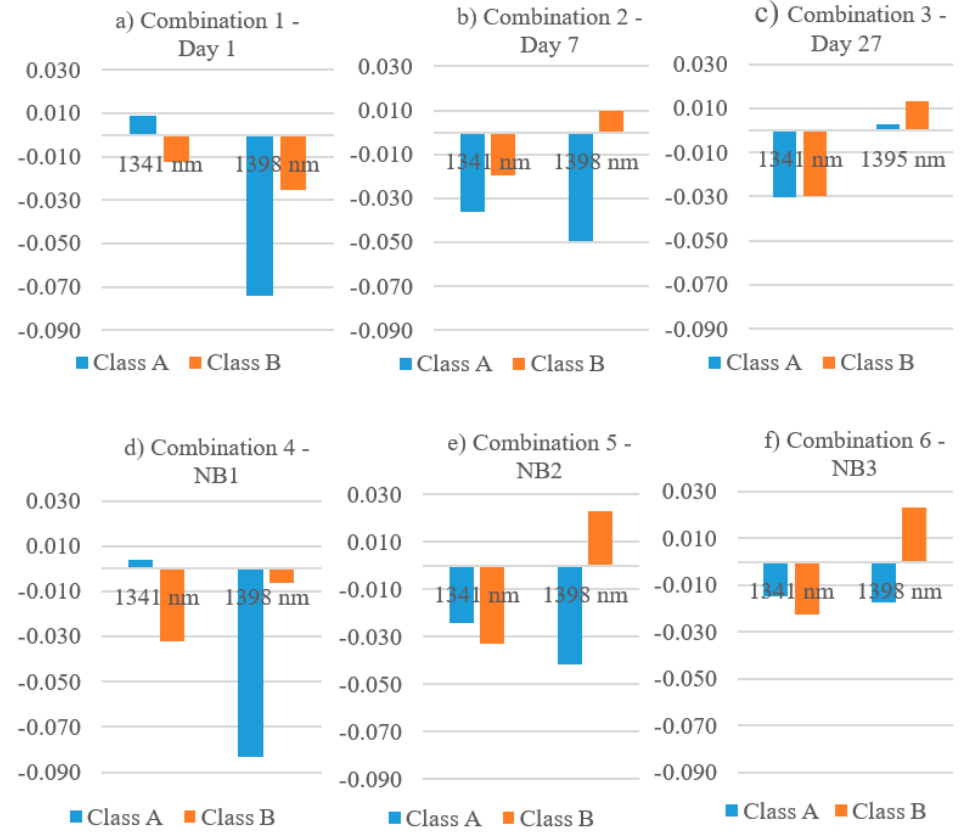
Figure 12. Reflectance intensities of classes A and B at 1341 and 1398 nm for combinations 1–6 ( a – f ).